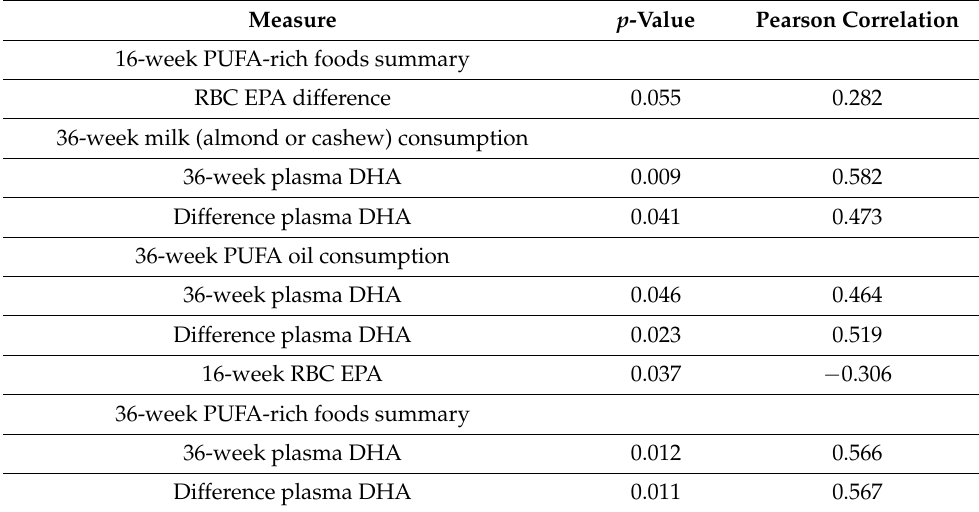
Table 4. Correlation between self-reported PUFA-rich food consumption and maternal blood and plasma DHA or EPA